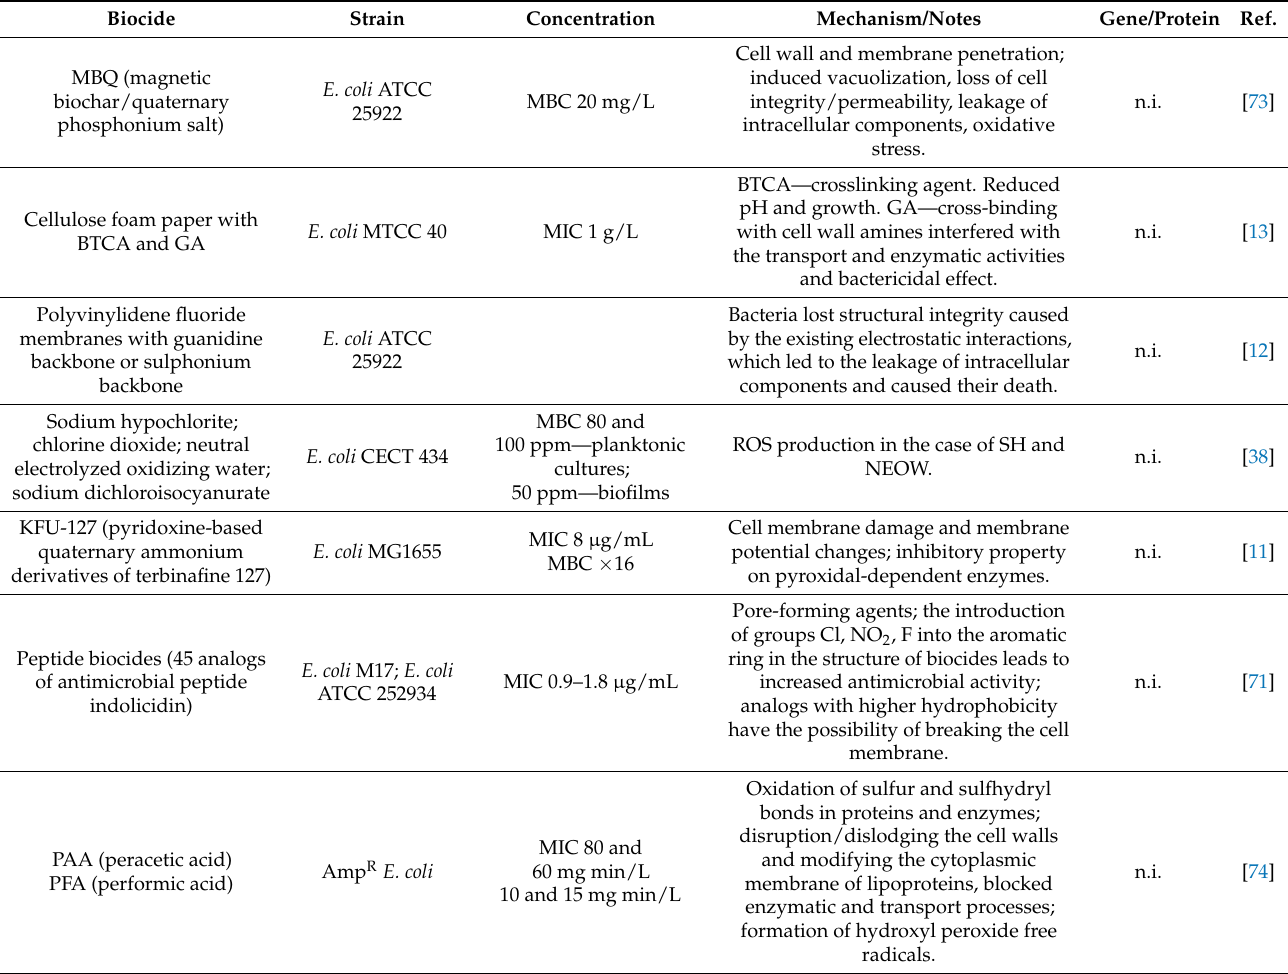
Table 1. Biocides and their impact on Escherichia coli